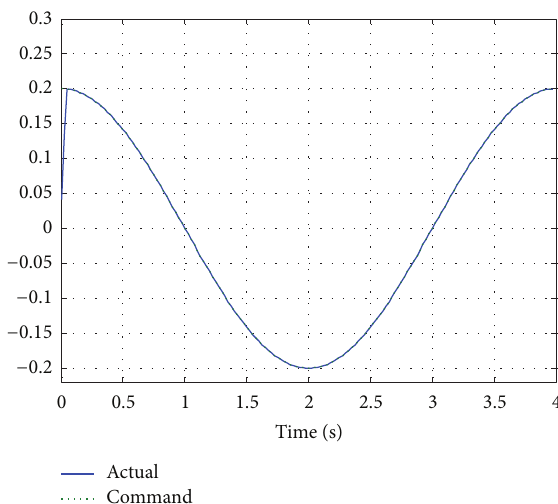
Figure 10: The response of angle of attack.